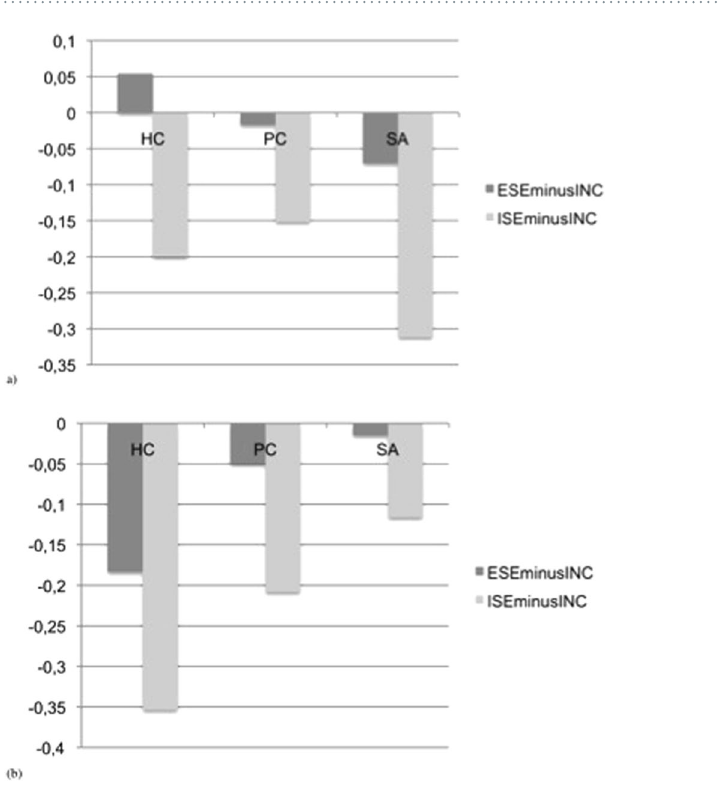
Figure 3. Betas values of brain activation (arbitrary units) during contrasts of interest ES vs. INC and ISE vs. INC in the three groups in ( a ) left supramarginal gyrus ( − 39 − 36 18) and ( b ) left posterior insula ( − 39 −